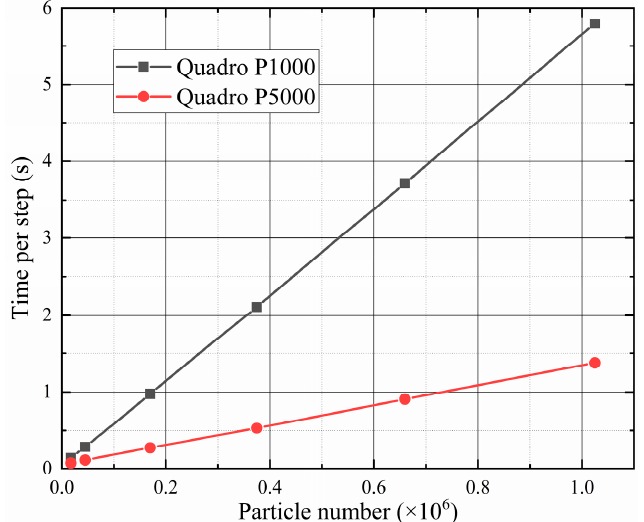
Figure 6. The relationship between calculation time per step and particle number on different GPU cards.